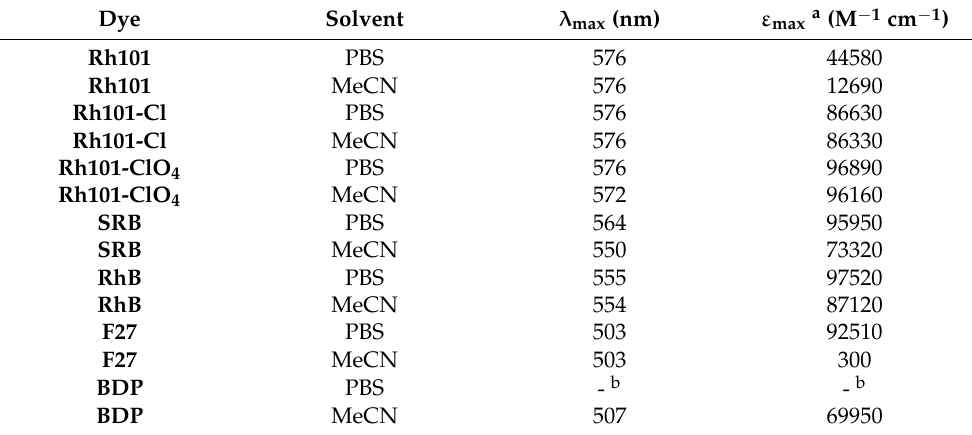
Table 2. Molar absorption coefficients (M − 1 cm − 1 ) of dyes in acetonitrile and PBS buffer at the corresponding absorption